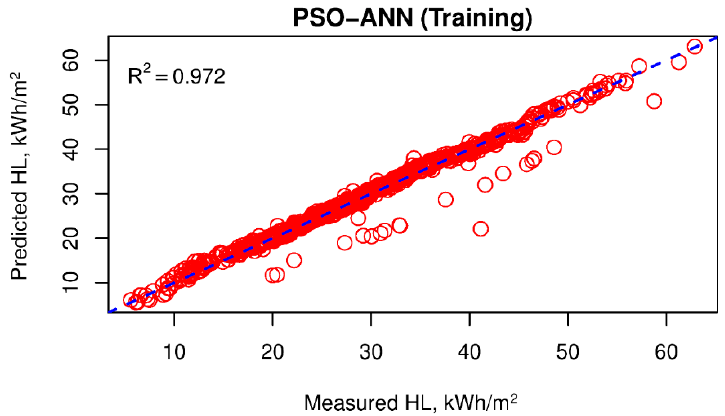
Figure 12. HL predictions on the training dataset of the PSO-ANN model.